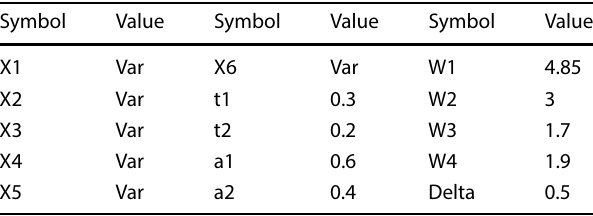
Table 1 Main design parameters of the microgripper Symbol